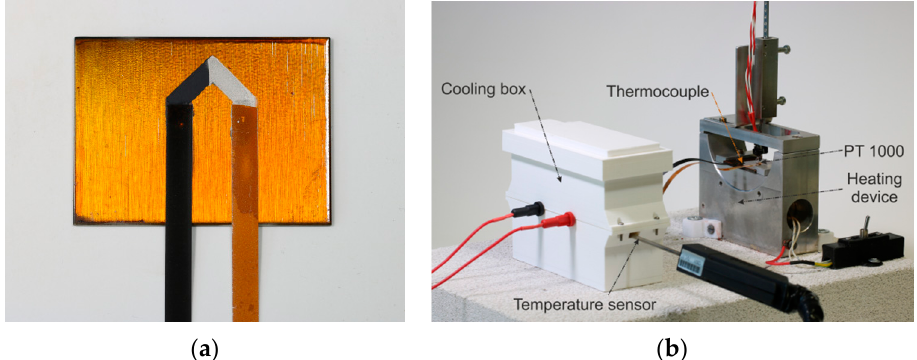
Figure 2. ( a ) spray processed thermocouple on metal substrate with polyimide connections before top coating; ( b ) Thermocouple test rig consisting of the heating device, a PT 1000 (for measuring the